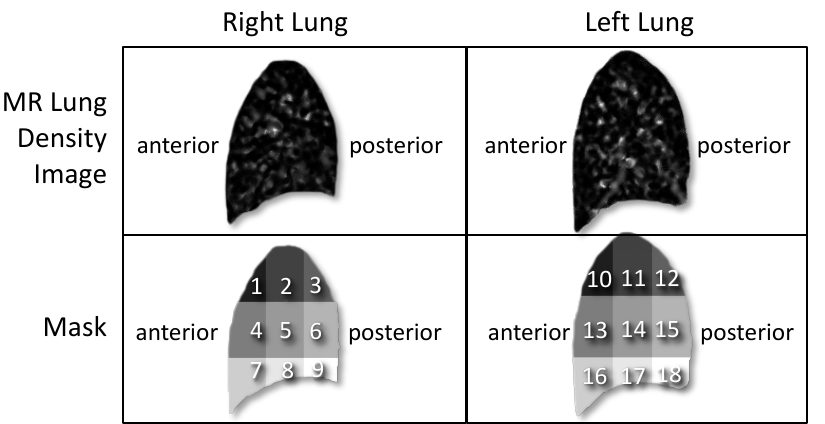
Figure 2. Demonstration of original MR lung density images ( top row ) with corresponding masks identifying the 18 ROIs across the right and left lungs ( bottom row ).